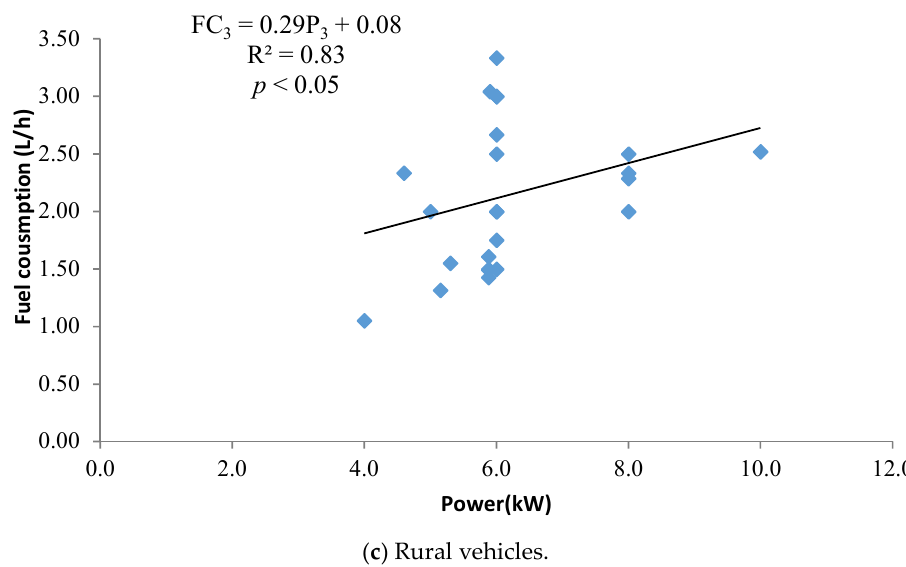
Figure 2. The relationship between power and hourly fuel consumption for three kinds of agricultural machinery. Table 2. Hourly fuel consumption estimates.